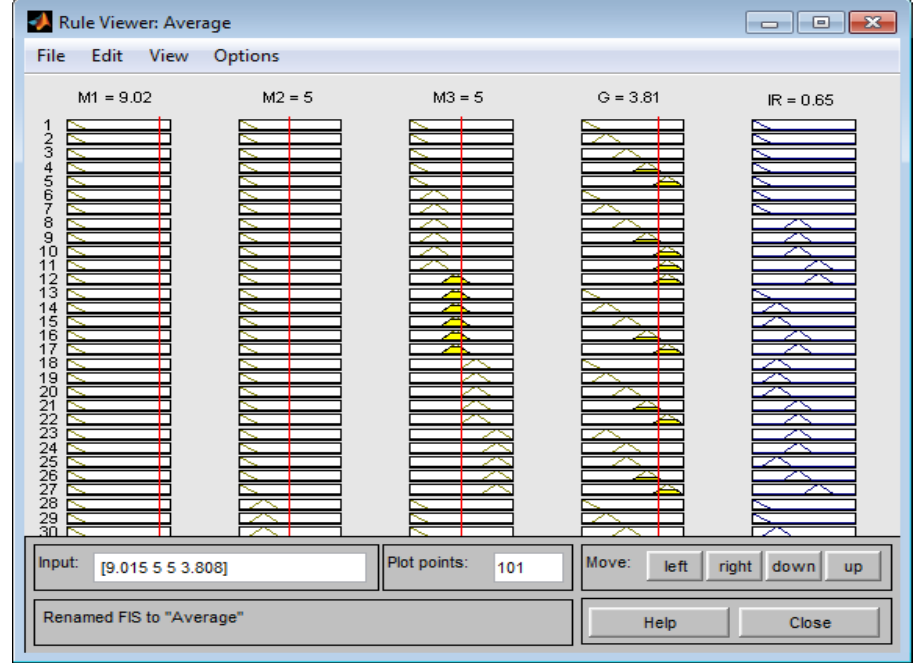
Figure 13. Example of A RB fuzzy rules used in top-level fuzzy logic.